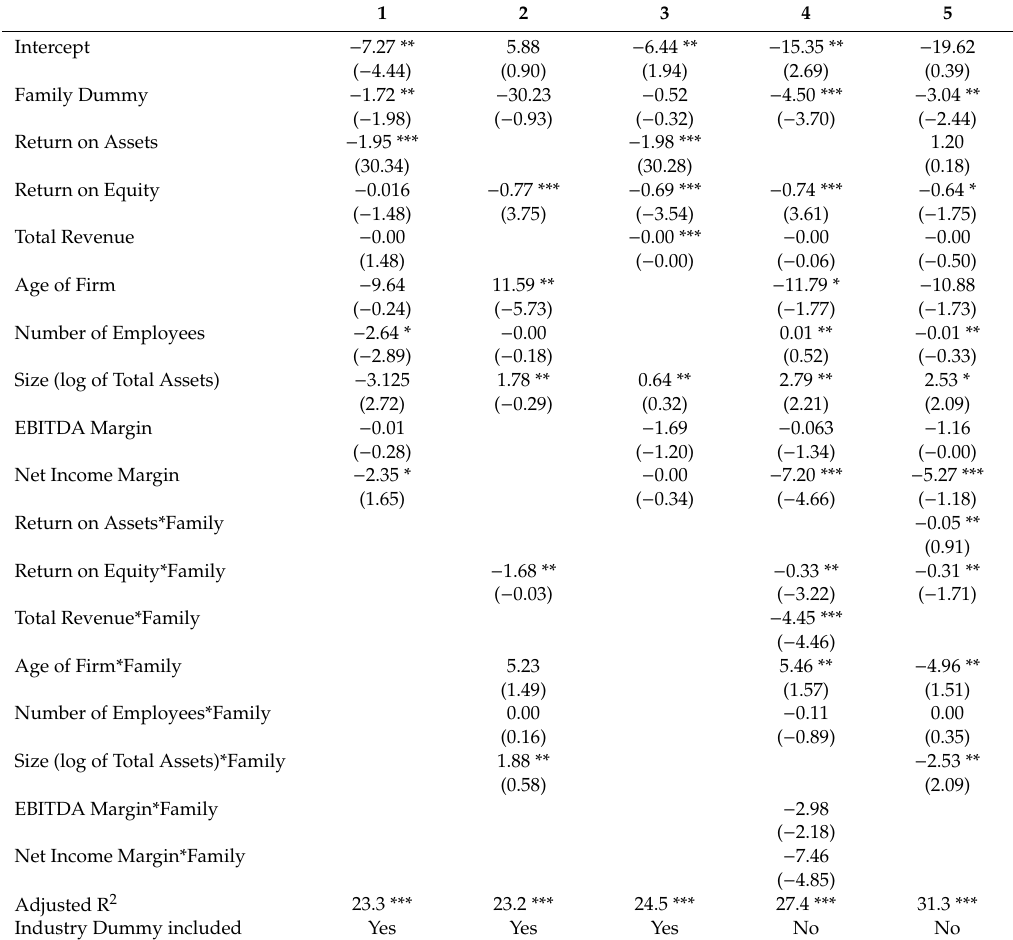
Table 4. Interest Coverage Ratio